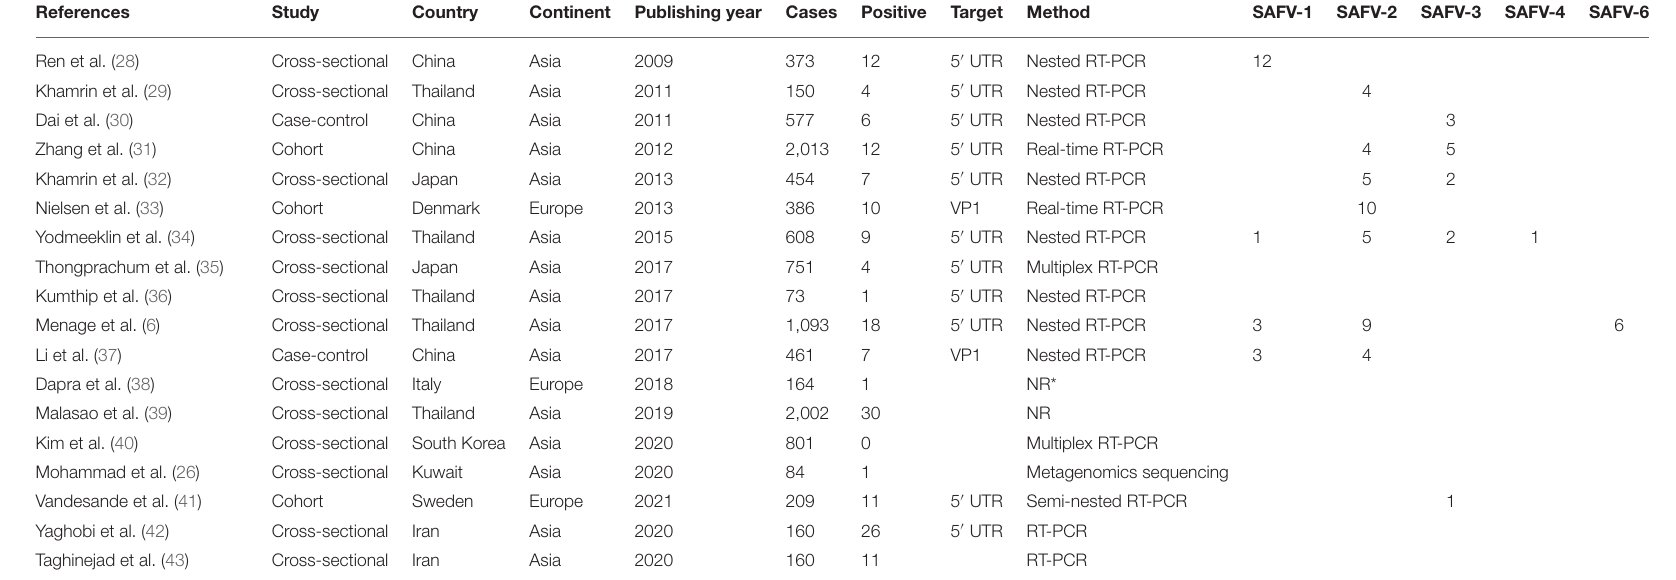
TABLE 2 | The general characterization of Saffold virus